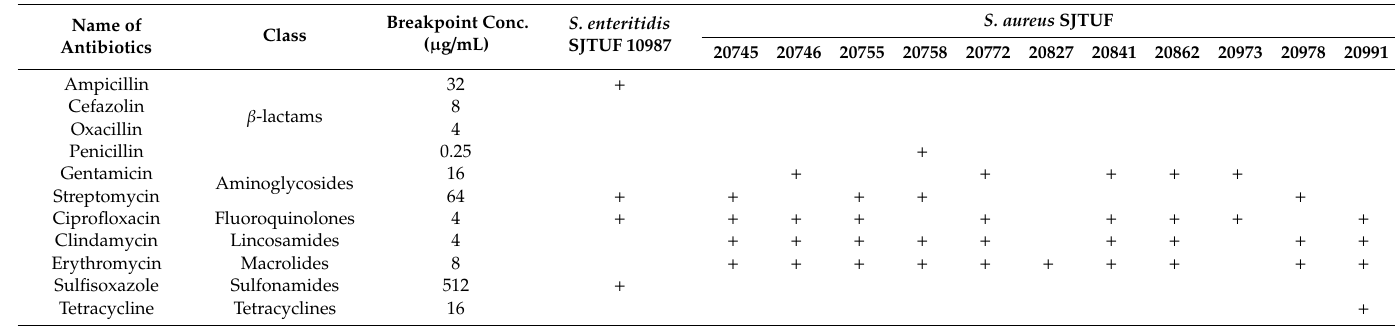
Table 2. Verification of drug-resistant